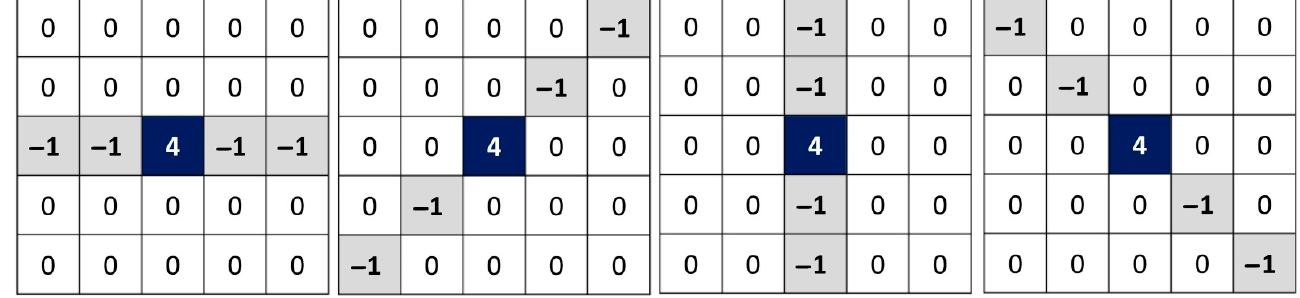
Figure 2. Four commonly used kernels in the case of impulsive noise identification. Angle of rotation (from left to right): 0, π /4, π /2, 3 π /4.